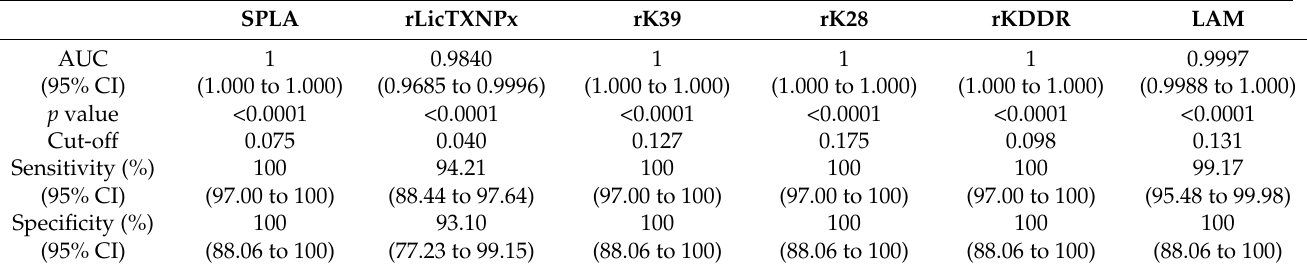
Table 2. Receiver operating characteristic curve analysis using the Leish+ and Leish- cohorts for the Leishmania -specific antigens used in the serological